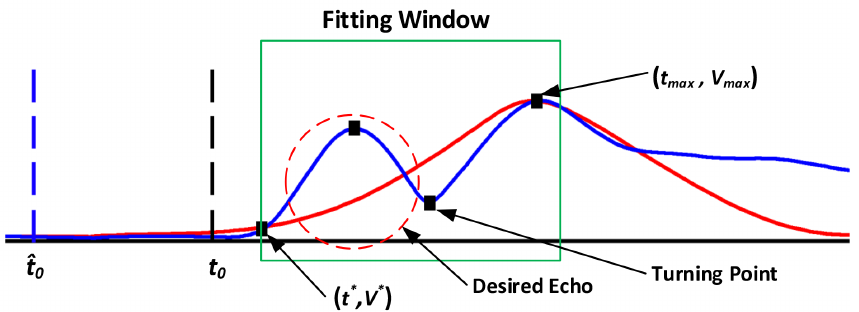
Figure 5. Double peaks phenomenon of envelope waveform. (Blue line: echo envelope; red line: curve-fitting result.)